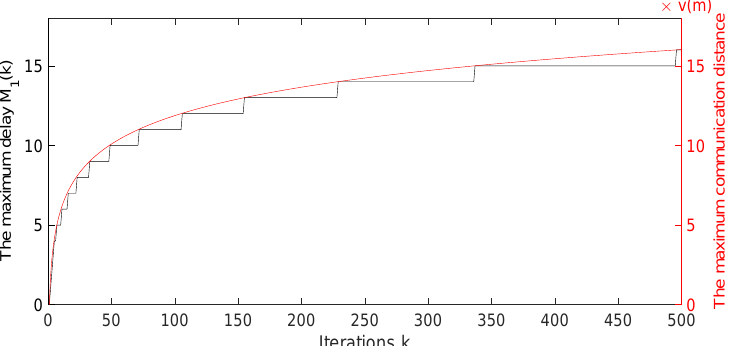
( 1 ) ( k ) between agents and the maximum delays max